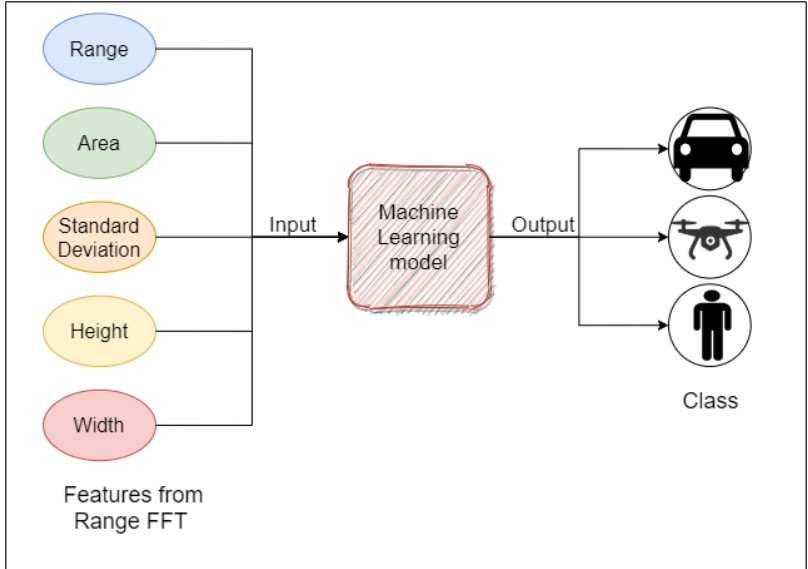
Figure 9. Overview of machine learning